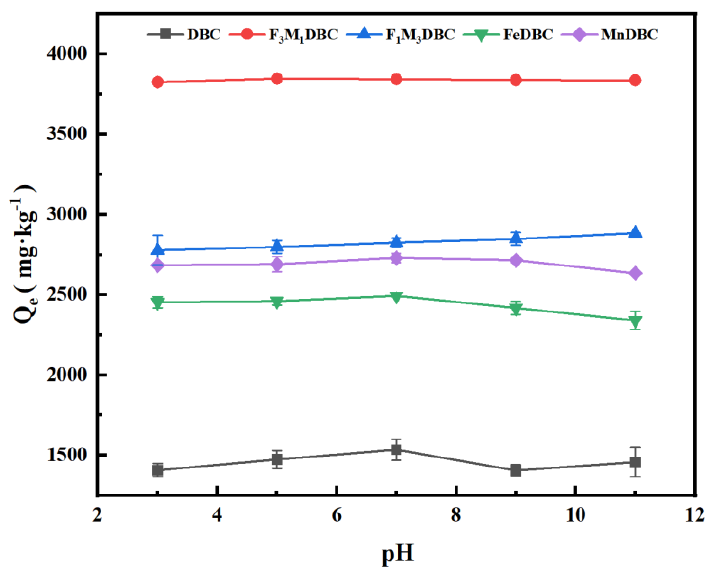
Figure 5. The atrazine adsorption capacity (Qe) of original biochar and modified biochar in different pH values.